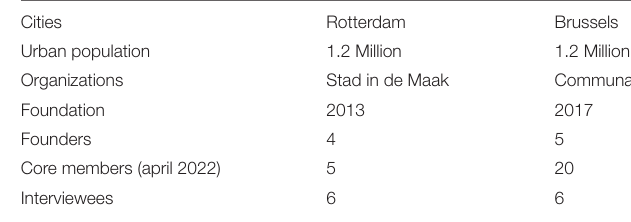
TABLE 1 | Case studies and